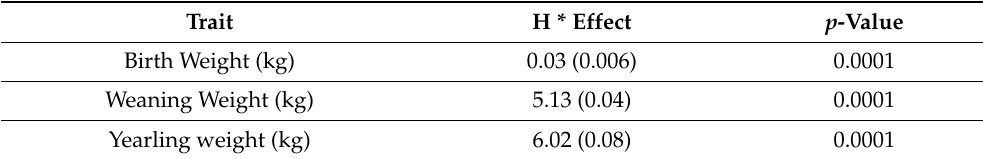
Table 2. Linear effects of genomic heterozygosity on growth